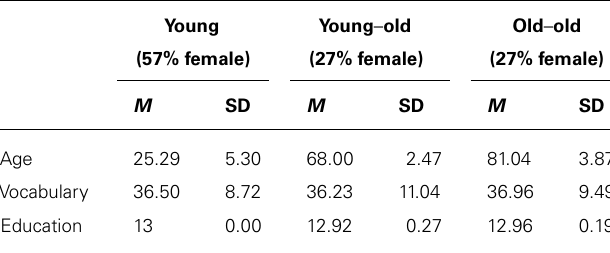
Table 1 | Characteristics of the participants by age